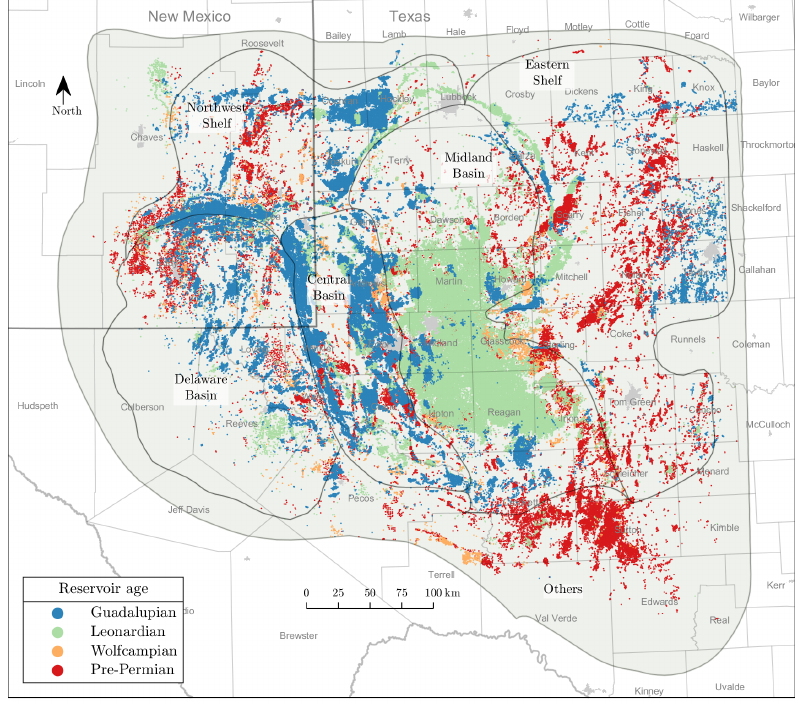
Figure 3. The map of all 484,759 vertical wells in the Permian Basin, colored by four different reser- voir